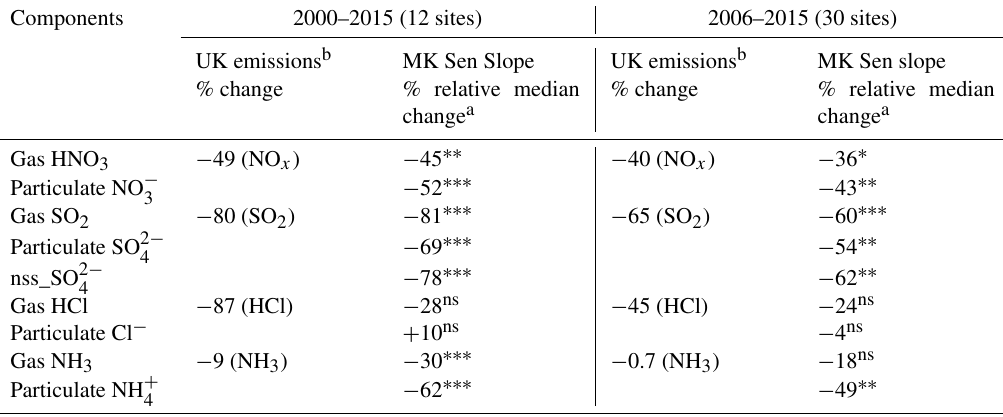
Table 5. Comparison of percentage change in estimated UK NO x , SO 2 , and NH 3 emissions reported by the National Atmospheric Emission Inventory (NAEI, 2018) with % change between 2000 and 2015 (12 sites with complete time series) and between 2006 and 2015 (30 sites with complete time series) in annually averaged HNO 3 / NO − Network (AGANet), and annually averaged NH 3 / NH + et al.,